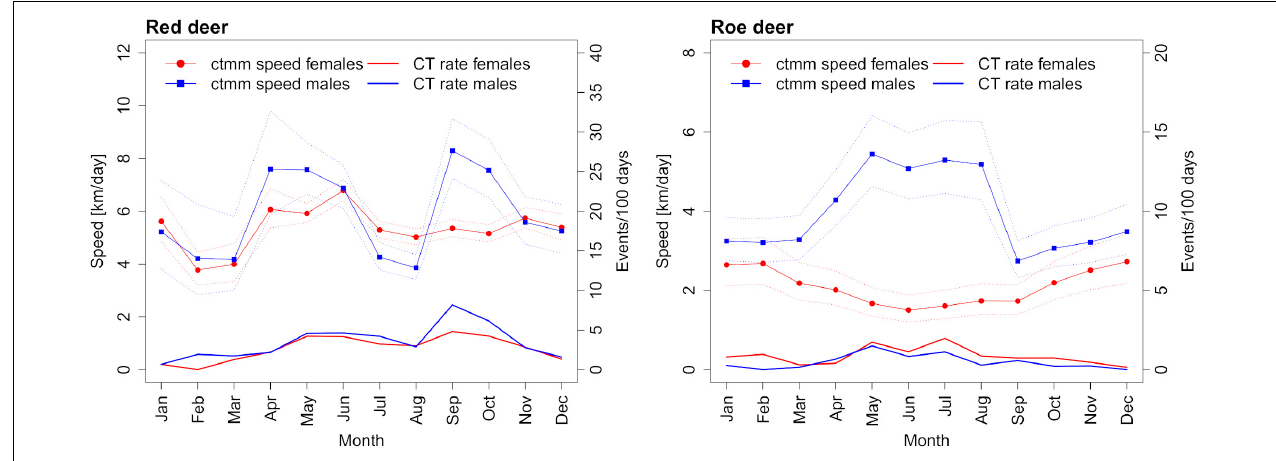
FIGURE 3 | Seasonal trends in movement speed, as estimated by continuous time-movement modeling (ctmm), compared with the camera trapping (CT) rates.